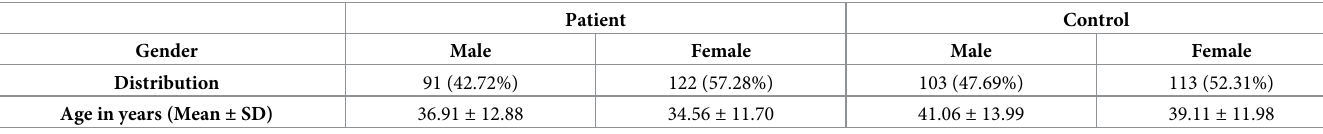
Table 1. Demographic characteristics of the study groups.